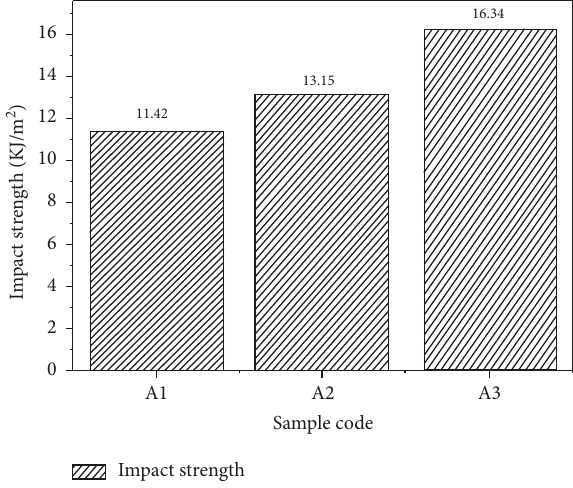
Figure 6: Impact strength